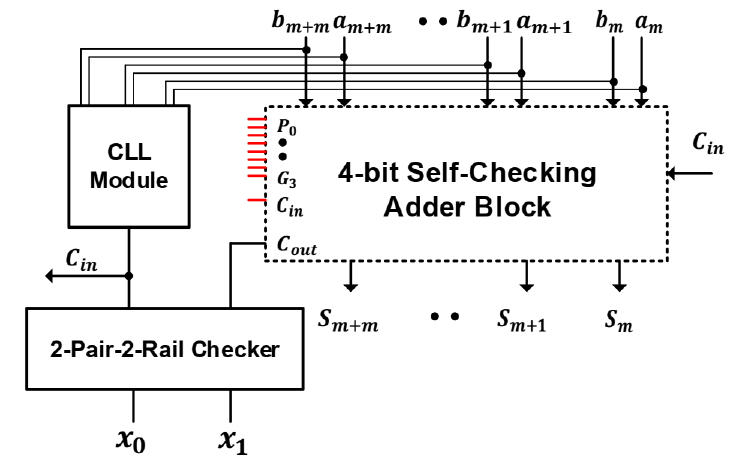
Figure 5. Self-checking PRCA